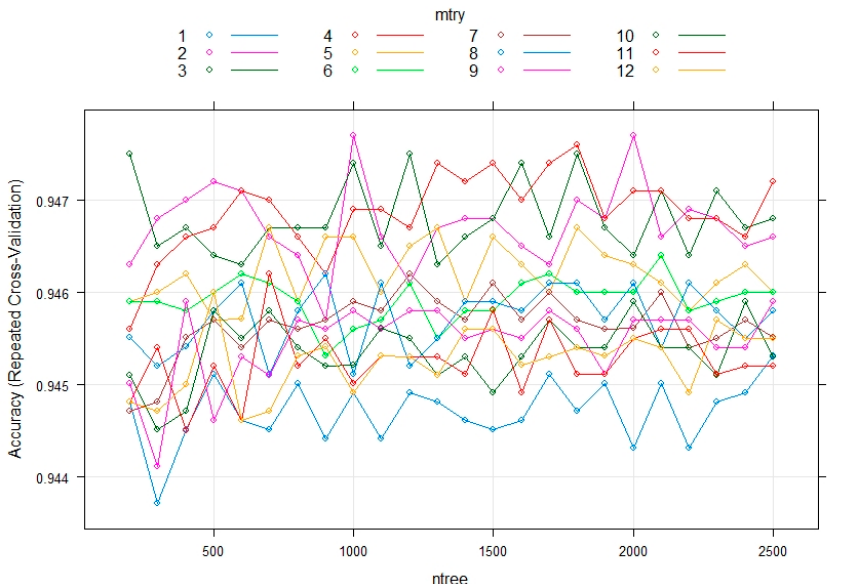
Figure 7. Custom tuning of Random Forest parameters in R. This diagram illustrates how Random Forest performs in terms of accuracy for different combinations of the parameters under tuning (mtry and ntree) and for 10-fold repeated cross-validation.